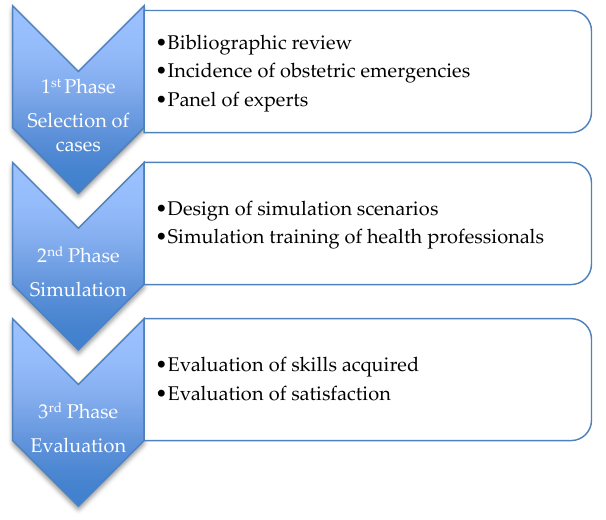
Figure 1. Scheme of the study